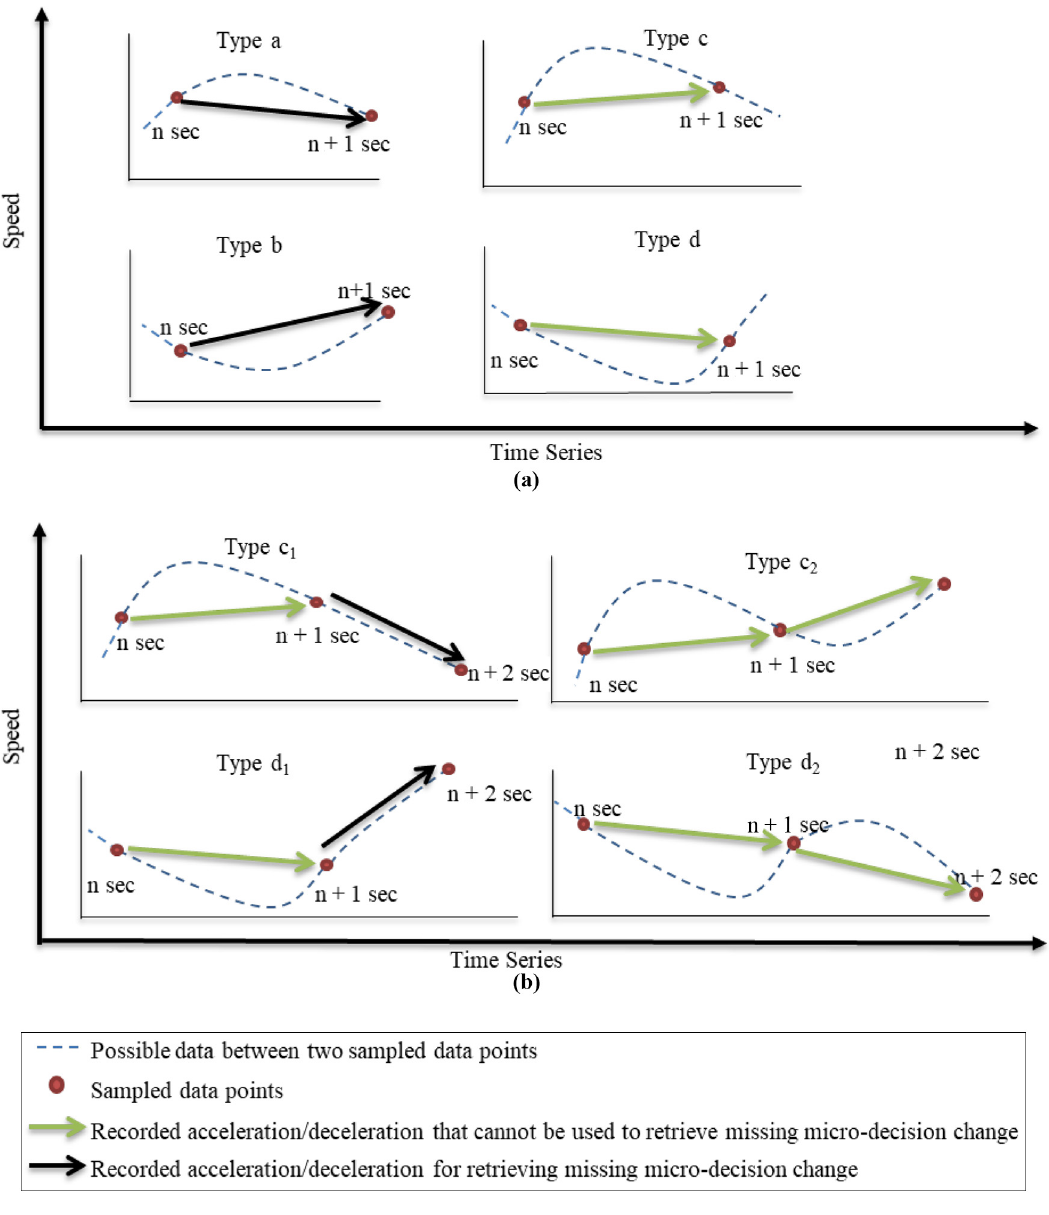
Figure 3 Examples of missing information when examining speed data over